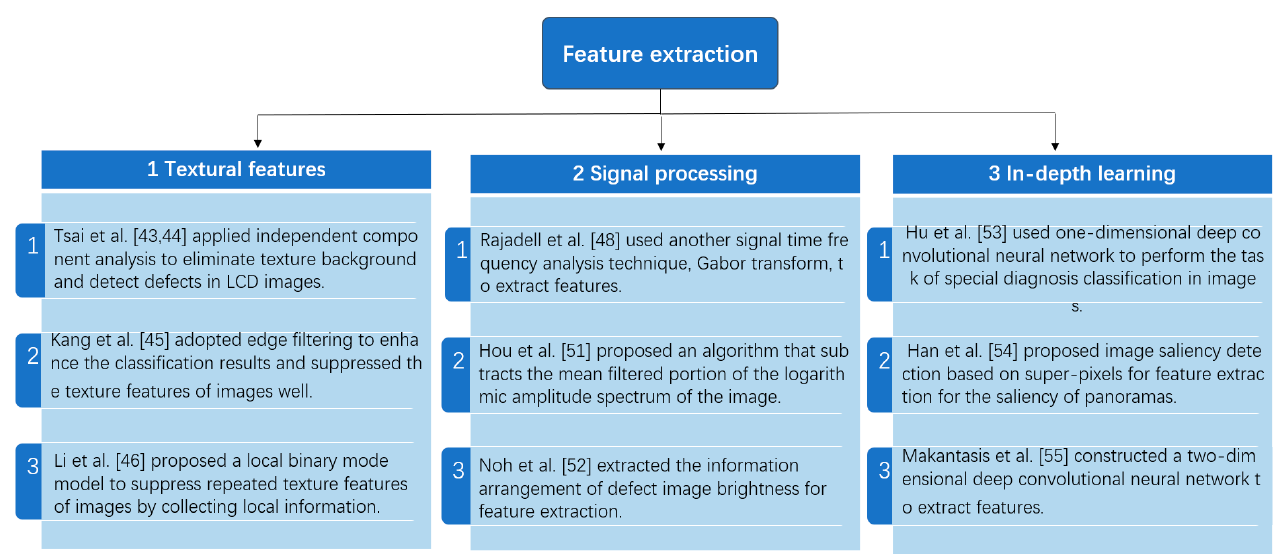
Figure 8. Common feature extraction for Mura defects methods.